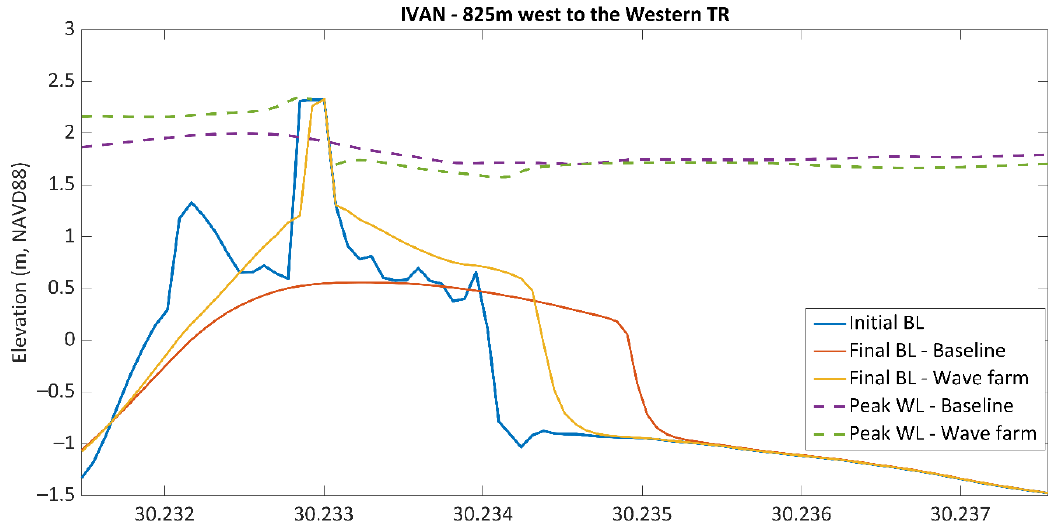
Figure 8. Hurricane Ivan bed levels (BL) and water levels (WL) under baseline and wave farm scenarios at the location on Dauphin Island, AL where the maximum dune height difference between the two scenarios occurs.